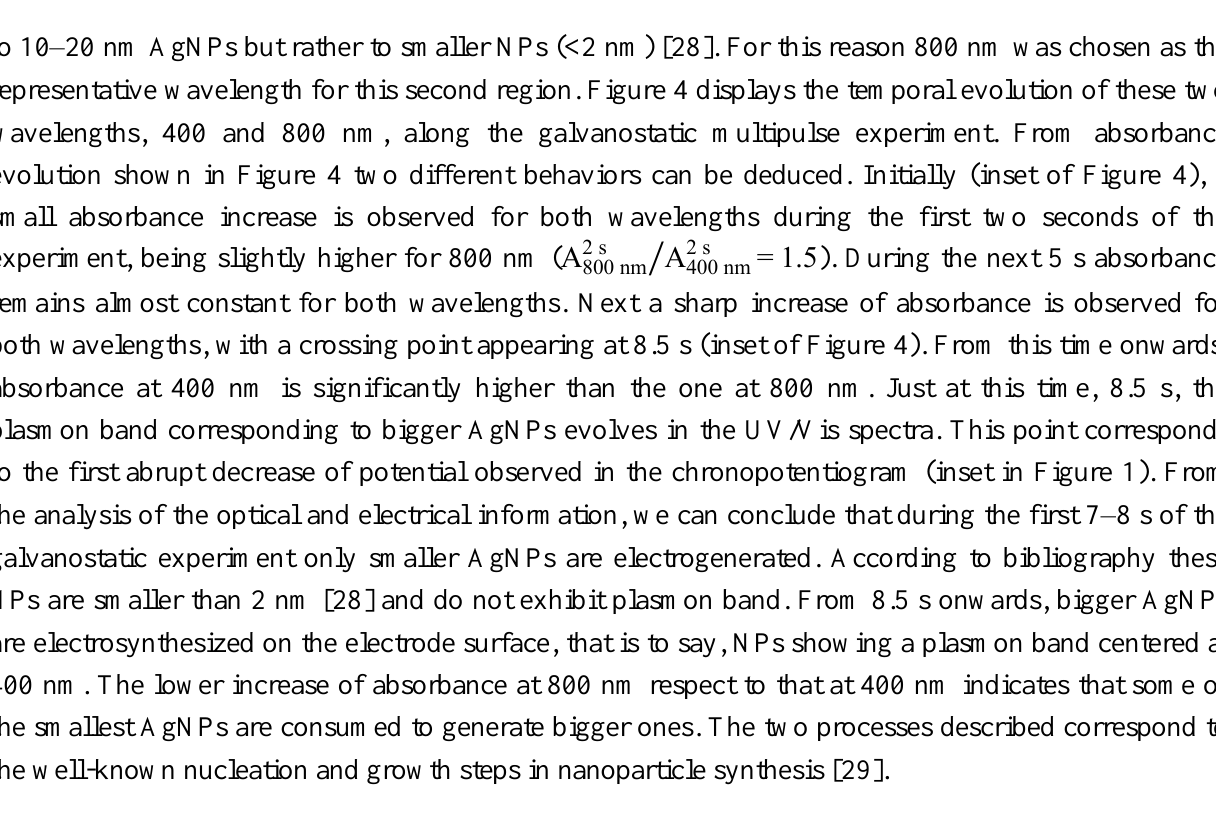
Figure 4. Absorbance evolution during the galvanostatic multipulse synthesis of AgNPs at (─) 400 and (─) 800 nm. Pink lines (••) mark the end of each reduction pulse and blue lines (─ ─) the end of each oxidation pulse. (Inset: Zoom corresponding to the first 12 s of the galvanostatic experiment). Experimental conditions as in Figure